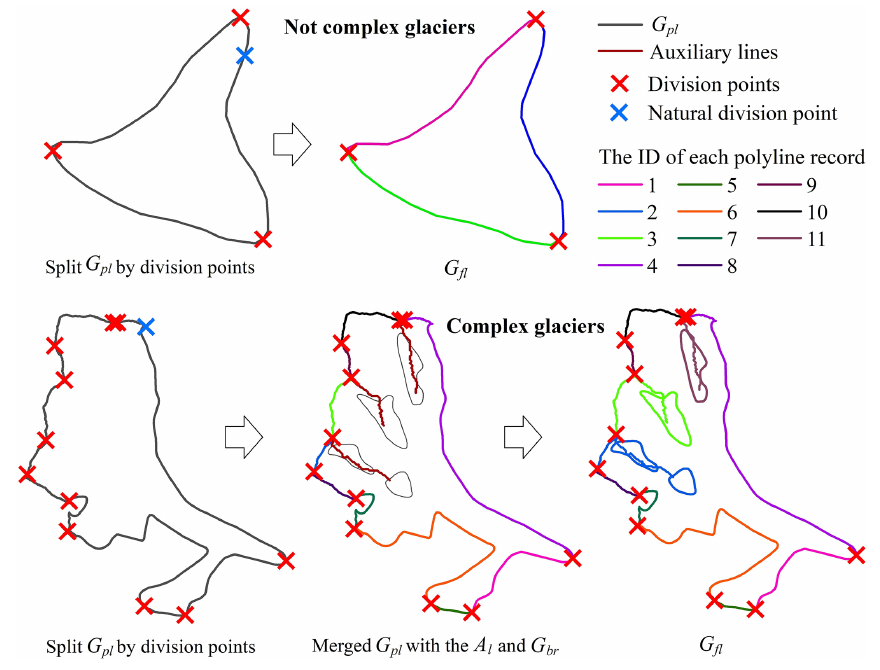
Figure 5. The schematic of extracting the polyline features of glacier surface.